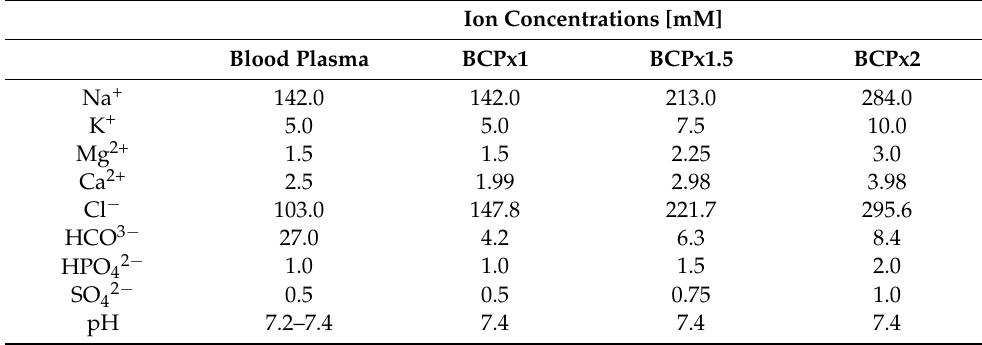
Table 1. Ion concentrations and pH value of modified biomimetic calcium phosphate (BCP) coating solutions in comparison to blood